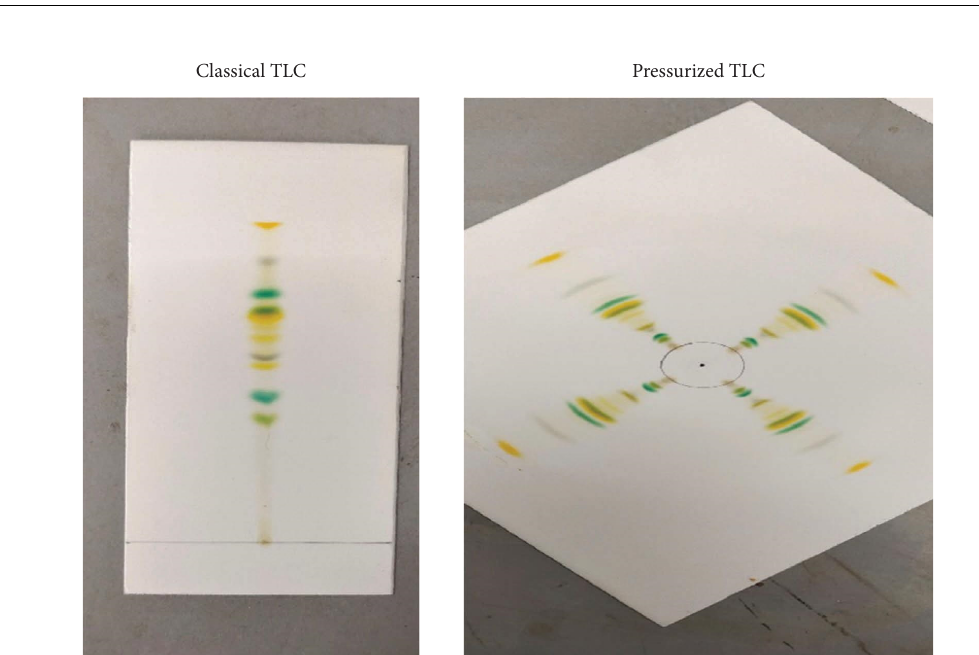
Figure 5: Separation of pigments from the spinach extract by classical and pressurized